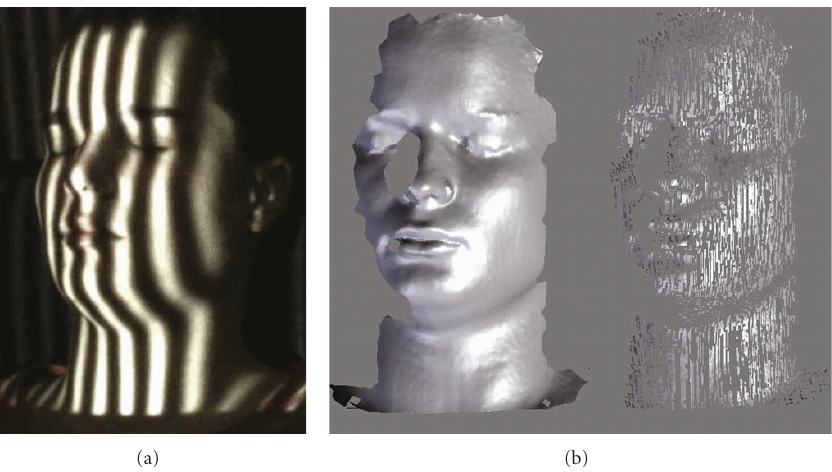
Figure 8: An example of 3D human face reconstruction. (a) Image during pattern projection. (b) Acquired mesh surface: left, dense reconstruction obtained by our method; right, sparse reconstruction obtained by the G-S